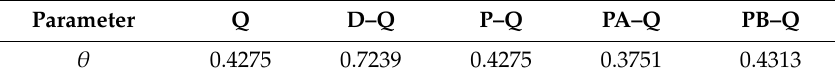
Table 8. Parameter θ of the Frank